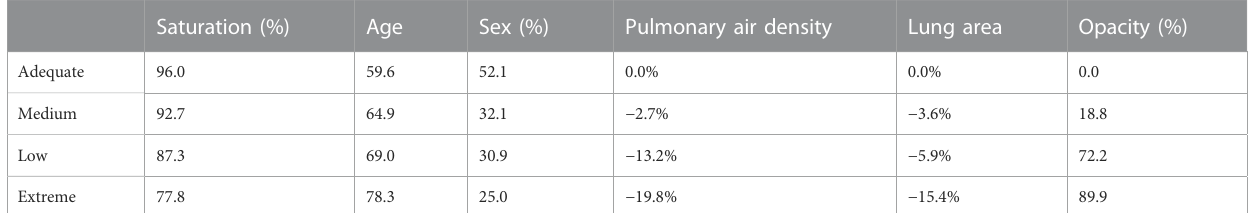
TABLE 2 Average values (%) of the study variables per saturation level. Gender is expressed as the percentage of women. For better interpretation, image diagnostic variables are expressed in terms of deviation from the average healthy patient (hence, the 0% values in the adequate level).